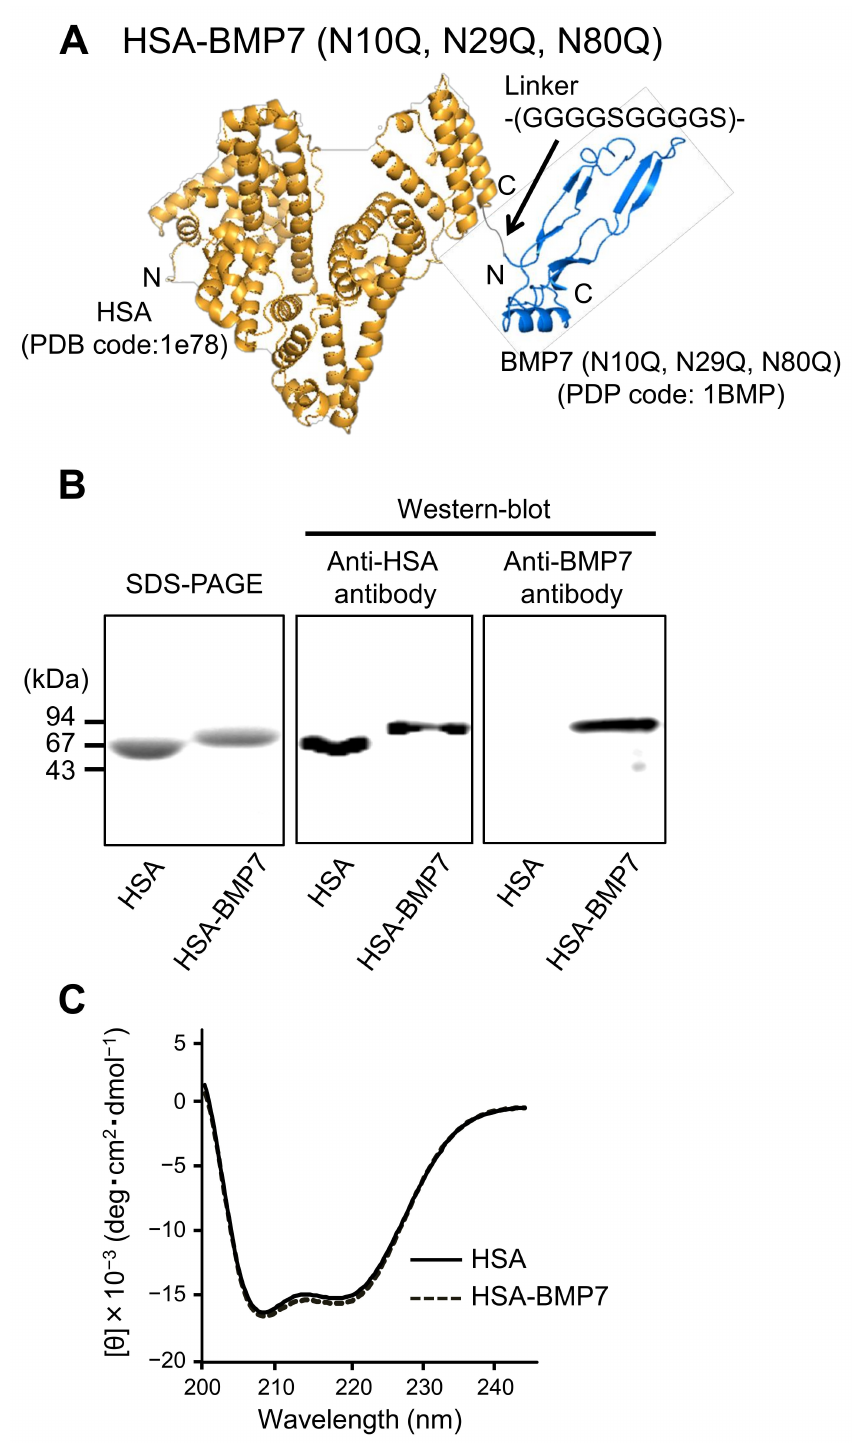
Figure 1. Characterization of the HSA-BMP7 fusion protein. Structural diagram (image view) of the HSA-BMP7 fusion protein containing 3 engineered point mutations at positions 10, 29 and 80 (N10Q, N29Q and N80Q) at which wild-type human BMP7 has N-glycosylated sites. (GGGGSGGGGS) indicates the polyglycine and serine linker ( A ). Reduced SDS-PAGE of HSA-BMP7 and Western blot analysis of HSA-BMP7 ( B ). The transferred PVDF membranes were incubated with primary antibodies against HSA or human BMP7. Equal amount of proteins (1 µ g/lane) were electrophoresed. Far-UV circular dichroism spectra of HSA and HSA-BMP7 ( C ). The protein concentration was 2.5 µ M in PBS (pH